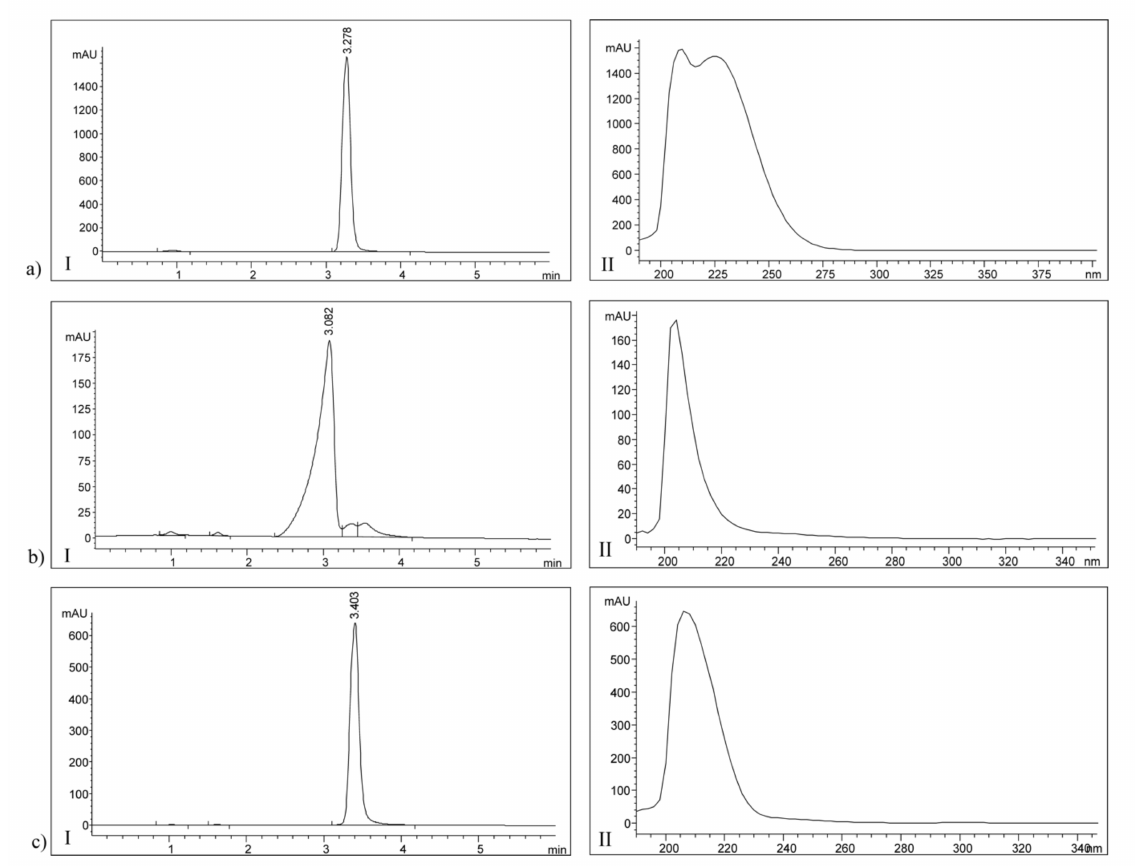
Figure 8. The high-pressure liquid chromatography (HPLC) chromatograms and UV spectra of standard solutions of ( a ) NIPAM, c = 0.253 mg/cm 3 , ( b ) AA, c = 0.150 mg/cm 3 and ( c ) EGDM, c = 0.132 mg/cm 3